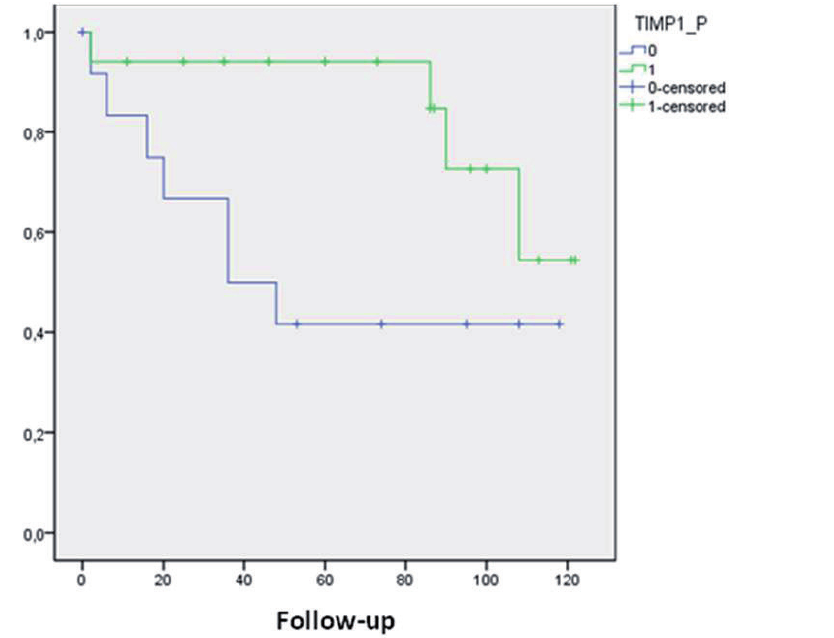
figure 3 - Kaplan-Meir curve of biochemical recurrence-free survival according to TIMp-1 immune-expression. Kaplan-Meier curve shows a median biochemical recurrence free survival of 105 months for patients with TIMp-1 positive (1-green line) against 62.8 months for patients with TIMp-1 negative (0-blue